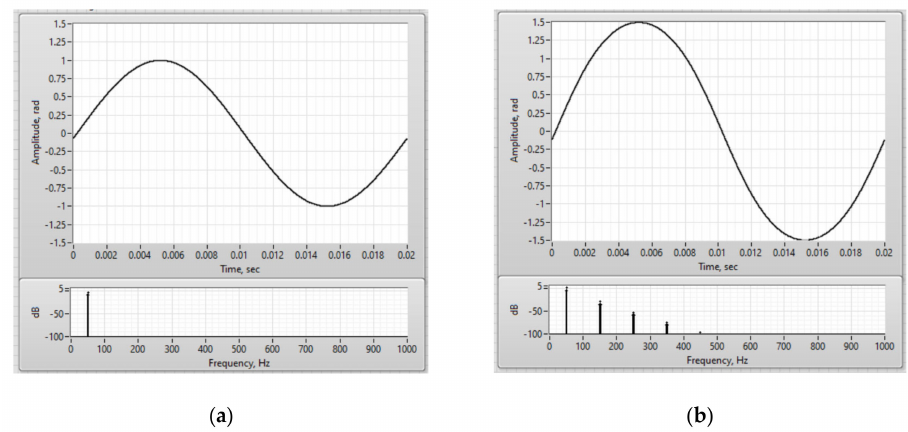
Figure 19. Demodulated current signal and its spectrum: ( a ) The case of ideal 1 plate with length of 0.1 λ